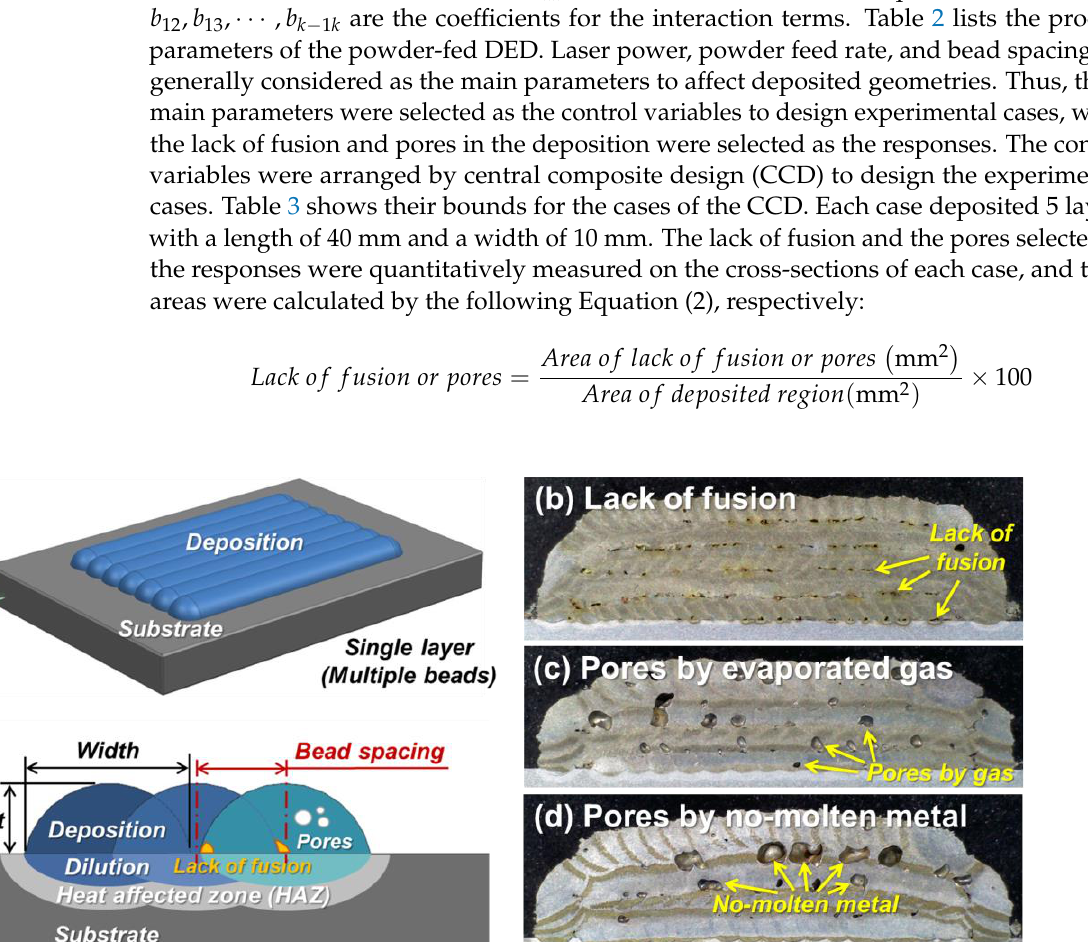
Figure 2. Schematics of ( a ) the powder-fed DED process and ( b ) multi-layered deposition.